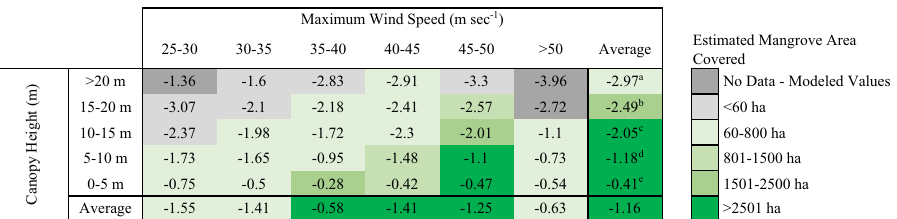
Fig. 3 Changes in average canopy height, in meters, from Hurricane Irma were greatest in taller mangrove forests. Wind speed classes re fl ect the maximum one-hour wind speed exposure from Hurricane Irma (Materials and methods are available as Supplementary materials). Colors indicate the mangrove area covered by each height and wind class. Lettered superscripts denote classes that are statistically signi fi cant ( p < 0.00001) using a one-way ANOVA paired with a post-hoc Tukey test. Additional information on the standard errors and area estimates can be found in Supplementary Table